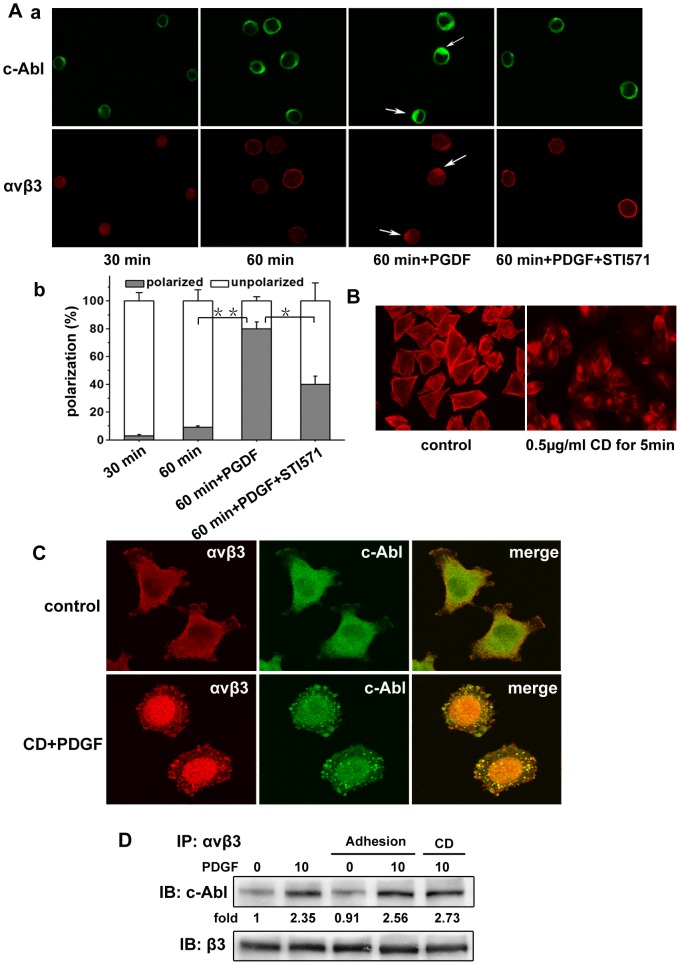
β3 integrin engagement and F-actin do not affect the interaction of c-Abl kinase and αvβ3 integrin.(A) a. Serum-starved A375 cells were digested with EDTA and suspended in serum-free medium for 2 h to restore the state of the cells. After that the cells were incubated on fibronectin-coated coverslips with or without PDGF stimulation for indicated times. Then, the cells were fixed and stained for c-Abl kinase and αvβ3 integrin. In inhibition experiments, cells were preincubated with STI571 for 10 min, and the inhibitor remained in the medium throughout the assay period. b. A375 cells were counted in 5–10 fields, and the percentages were calculated by dividing the number of polarized or unpolarized cells by the total number. Data were obtained from >25 cells for each field. (B) Cells were allowed to adhere and spread for 24 h, and Cytochalasin D (0.5 µg/ml) was added into the medium for 5 min. Then the cells were fixed and stained with phalloidin. (C) Serum-starved A375 cells were treated with Cytochalasin D (0.5 µg/ml) for 5 min and washed for three times with PBS. After stimulation with PDGF for 1 h, the cells were fixed and labeled with the antibodies of c-Abl kinase and αvβ3 integrin. (D) Serum-starved A375 cells in suspension, as indicated, were stimulated with PDGF or allowed to adhere for 1 h, or treated with Cytochalasin D (0.5 µg/ml) for 5 min. Thereafter, the cells were lysed and the supernatants were incubated overnight at 4°C with αvβ3 integrin antibody for immunoprecipitation. Immunoprecipitated complexes were collected with protein A-Sepharose beads, then were washed and resolved by SDS-PAGE and immunoblotted with indicated antibodies. Data are representative of three independent experiments.